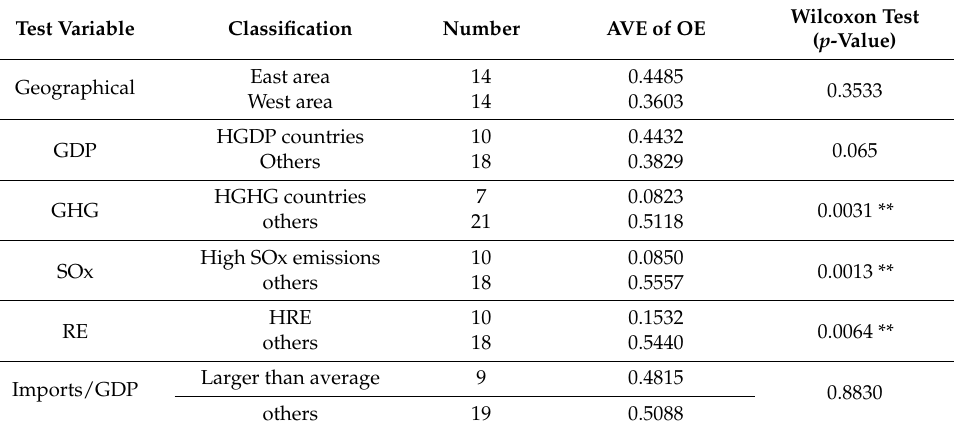
Table 8. The Wilcoxon test on AVE of OE.